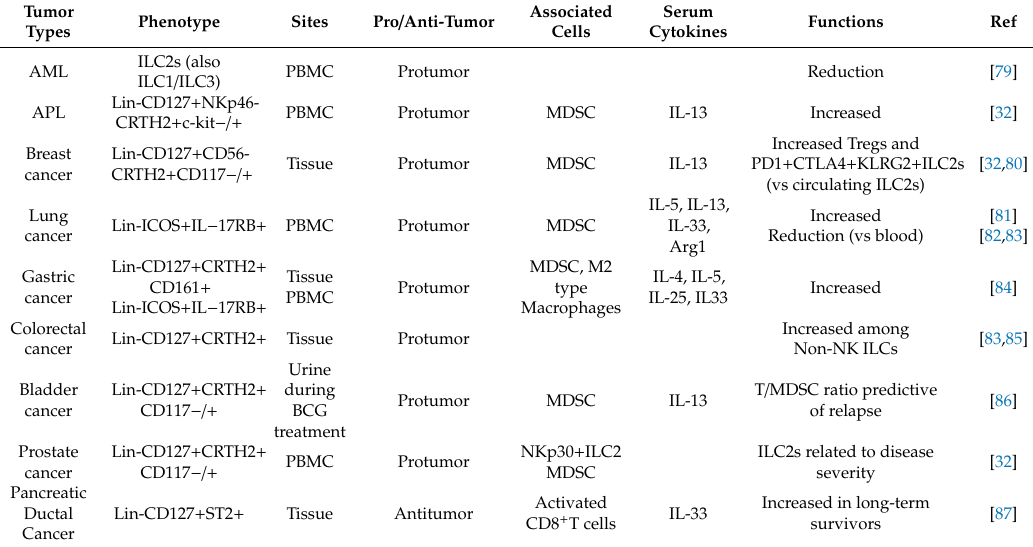
Table 1. Group 2 innate lymphoid cells (ILC2s) phenotype, distribution and pro- and antitumor function in